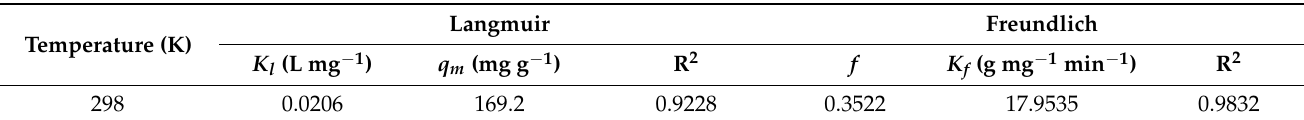
Table 4. Obtained key parameters from fitting results using pseudo-first-order and pseudo-second- order models.